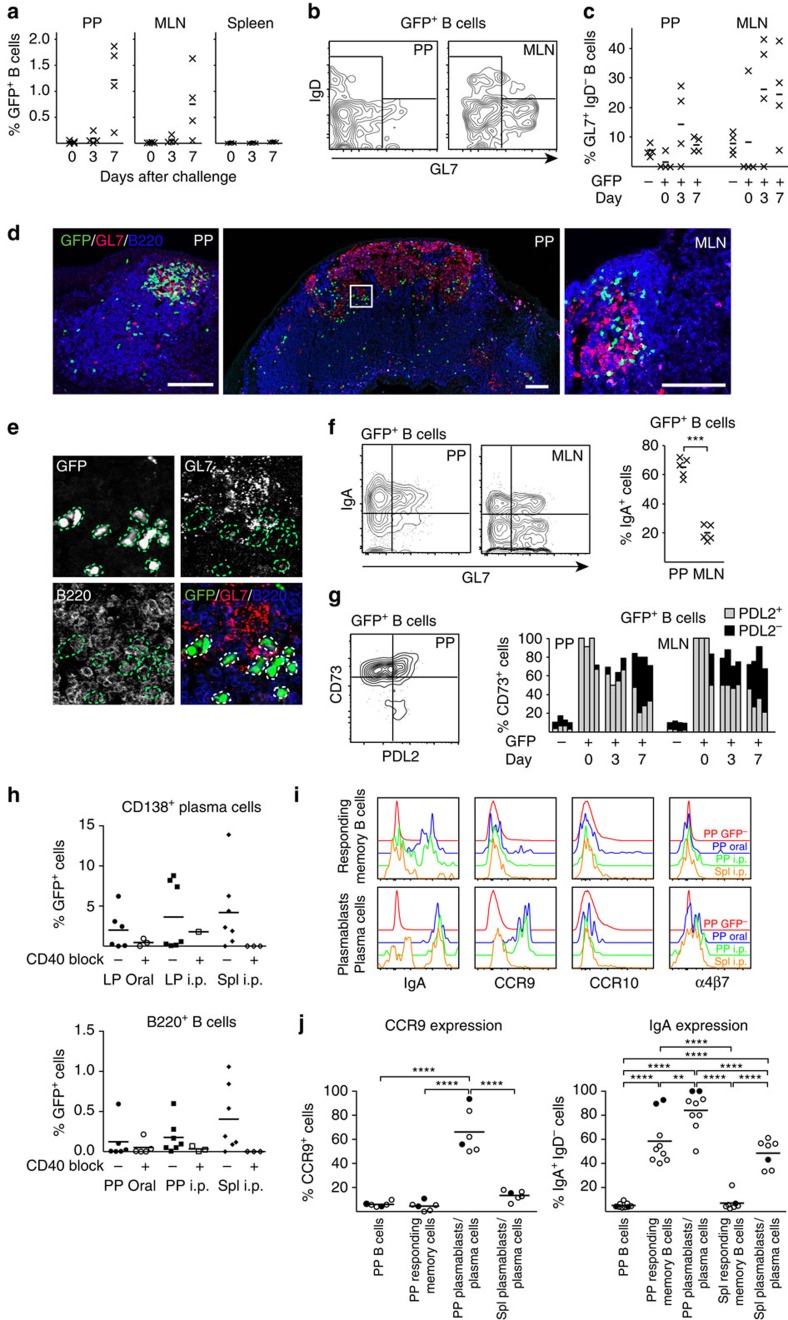
Memory B cells expand in and around pre-existing germinal centres on reactivation, but most cells do not acquire GL7 expression.(a) One year after oral priming immunizations, the proportion of NP-specific memory B cells in various tissues was monitored kinetically following a single p.o. challenge immunization with NP-CT. The frequency of NP-specific GFP+ cells among total CD19+B220+CD138− B cells at given time points was determined in individual mice (x; protocol as in Fig. 3a). (b,c) Flow cytometry analysis of GL7 and IgD expression on GFP+ memory B cells following the p.o. challenge. (b,c) The proportion of GFP+ cells that were GL7+ IgD− was determined using the indicated gates. (c) The percentage of GFP+ memory B cells that were GL7+IgD− was low in the PP, while it was two- to threefold higher in the MLN. (d,e) Antibody-labelled frozen sections of the PP and MLN were prepared 7 days after the challenge and analysed with confocal microscopy for GL7 (red) and B220 (blue) expression on expanding memory GFP+ (green) B cells. (e) Close-ups of the PP section marked in the mid panel in d with each individual channel shown in black and white and an overlay in colour in which individual GFP+ cells are circled to illustrate that most responding GFP+ memory B cells express B220, but not the GL7 marker even if located in a germinal centre. (f) Flow cytometry analysis on day 7 of IgA expression in responding GFP+ memory B cells in the PP and MLN. The percentage of IgA+ B cells/all GFP+ B cells in the PP or MLN in individual mice is given (right panel). (g) Flow cytometry analysis of the expression of CD73 and PD-L2 in responding GFP+ CD19+B220+CD138− memory B cells on different days following a p.o. challenge immunization. Each bar represents the percentage of memory B cells that co-express CD73 and PD-L2 (grey) or only CD73 (black). (h) Mice p.o. primed with NP-CT received a p.o. or i.p. challenge immunization 6 months later in the presence or absence of anti-CD40L Mab (clone MR-1), and the proportion of GFP+ cells/total B220+ B cells or CD138+ plasma cells in the lamina propria (LP), spleen (Spl) or PP in individual mice was determined using flow cytometry. The Mann–Whitney non-parametric test showed that GC disruption with anti-CD40L Mab significantly reduced GFP+ plasma cell numbers in the SI LP (P=0.0193) and responding B-cell numbers in the PP (P=0.0053). (i) NP-specific GFP+ cells in the PP or spleen in p.o. or i.p. challenged mice were divided into responding memory B220+ B cells and GFPhigh B220− plasmablasts/plasma cells (shown in Supplementary Fig. 6e,f), and the expression of IgA, CCR9, CCR10 and integrin α4β7 was determined by flow cytometry. As a control, GFP− B cells from the PP are included in each panel. (j) The proportion of mice that express CCR9 or IgA of the indicated GFP+ cell populations after an i.p. (open symbols) or p.o. (closed) challenge immunization. Significance was calculated with the Mann–Whitney test (f) and analysis of variance followed by Tukey's multiple comparison correction (j) and P values are given (**0.005≤P<0.01, ***0.001≤P<0.005, ****P<0.001). Data from four to five mice in each group in one representative experiment out of three giving similar results are shown.